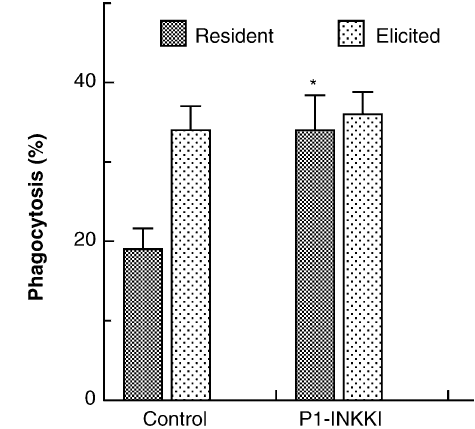
FIG. 4. Phagocytic activities of resident (dark shading) or elicited (light shading) peritoneal macrophages incubated with casoparan peptide INKKI (25 m g/ml) or saline (control group). The results are expressed as the mean 9 / standard error of the mean for 8 (cid:2) / 10 animals per group. *p B / 0.01, significantly different from the control